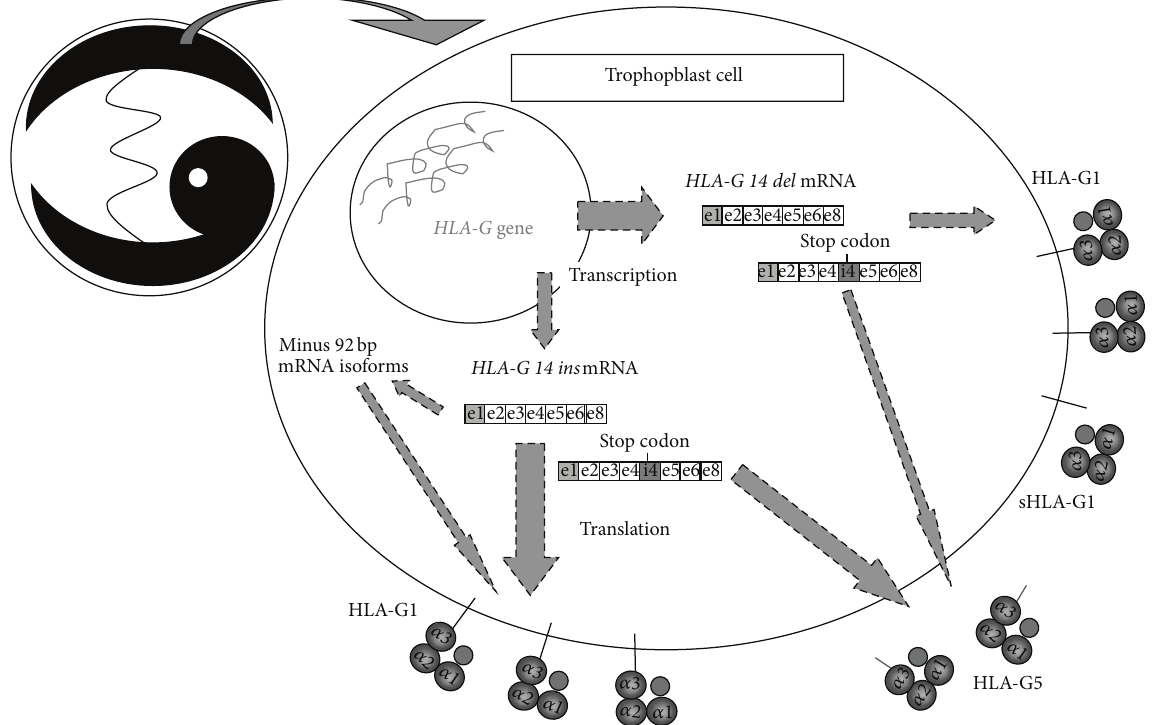
Figure 2: A simplified illustration of current status regarding the dynamic differences in transcription, mRNA stability, and translation in (extravillous) trophoblast cells between the 14bp del and 14bp ins HLA-G alleles. Only the full-length mRNA isoforms are shown for clarity. The relative thicknesses of the specific arrows are putative and should be interpreted with caution. The effect of the HLA-G 14bp ins/del polymorphism in the 3 󸀠 -untranslated region (3 󸀠 UTR) on HLA-G expression may be influenced by linkage disequilibrium with single nucleotide polymorphisms (SNPs) in the 3 󸀠 UTR, especially the +3142 and +3187 SNPs according to one study [29], and in the 5 󸀠 -upstream regulatory region. (Based primarily on [1,